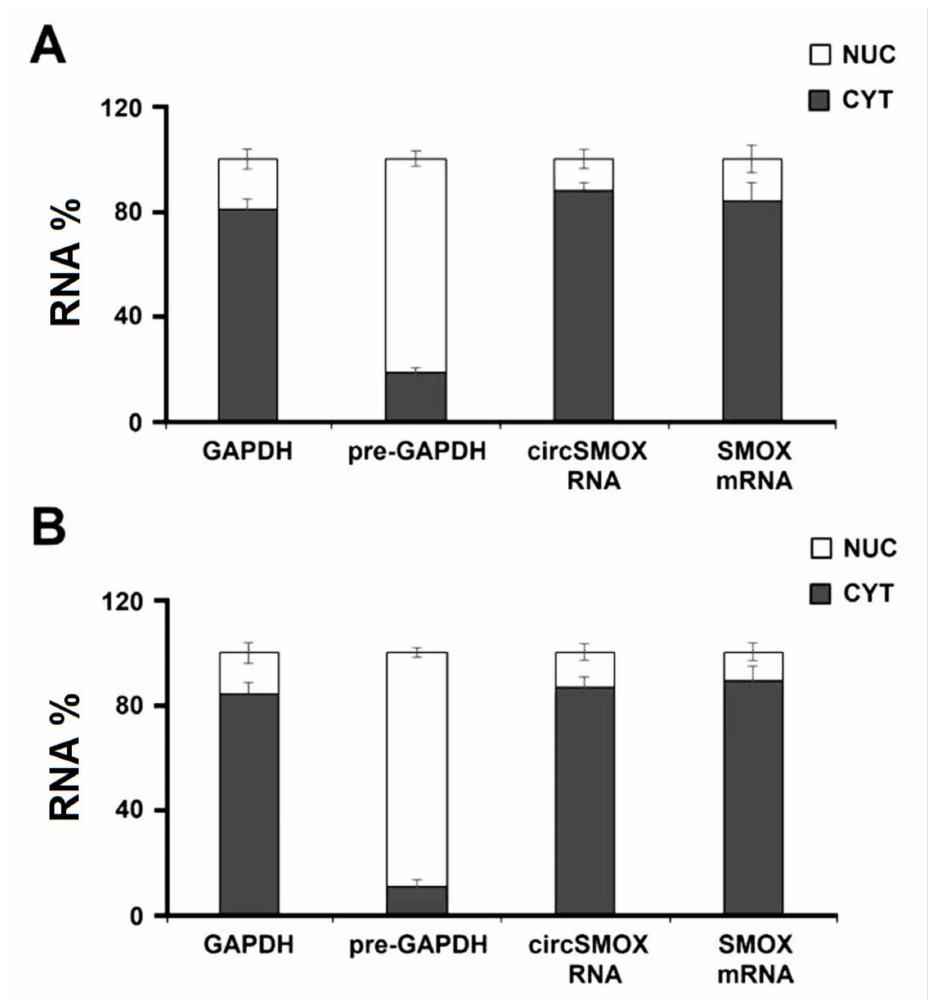
Figure 7. Cellular localization of circular SMOX RNA in atrophic C2C12 cells. The nuclear (NUC) and cytoplasmic (CYT) localization of linear and circular SMOX transcripts analyzed by qRT-PCR in murine myotubes untreated ( A ) and treated with DEXA ( B ). As control of the quality of the fractionation protocol, the precursor of GAPDH (pre-GAPDH) and the GAPDH transcripts have been used. RNA measurements were performed four independent experiments, each performed in triplicate. Bars show means and